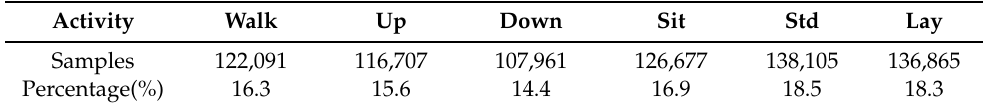
Table 3. Activities of UCI-HAR